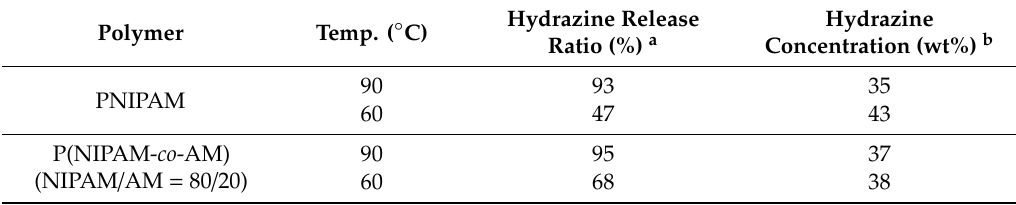
Table 4. Release of hydrazine by heating of gels of 35wt% hydrazine aqueous solution. Hydrazine Release Hydrazine Polymer Temp. ( ◦ C) Ratio (%) a Concentration (wt%) b 90 93 35 PNIPAM 60 47 43 90 95 37 P(NIPAM- co -AM) (NIPAM / AM = 80 / 20) 60 68